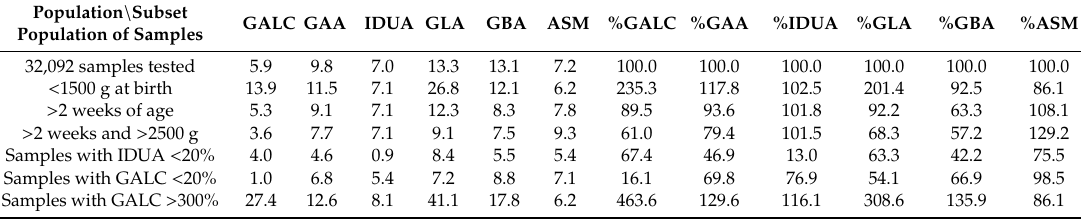
Table 3. Average enzyme activities ( µ mol / L / h) and percent of mean values (listed as %GALC, %GAA, etc.) of all samples tested (32,092) and stratified as indicated in the first column. The IDUA and GALC < 20% and GALC > 300% rows show the average activities and % of mean activities for each enzyme listed. Other enzymes are included for comparison of